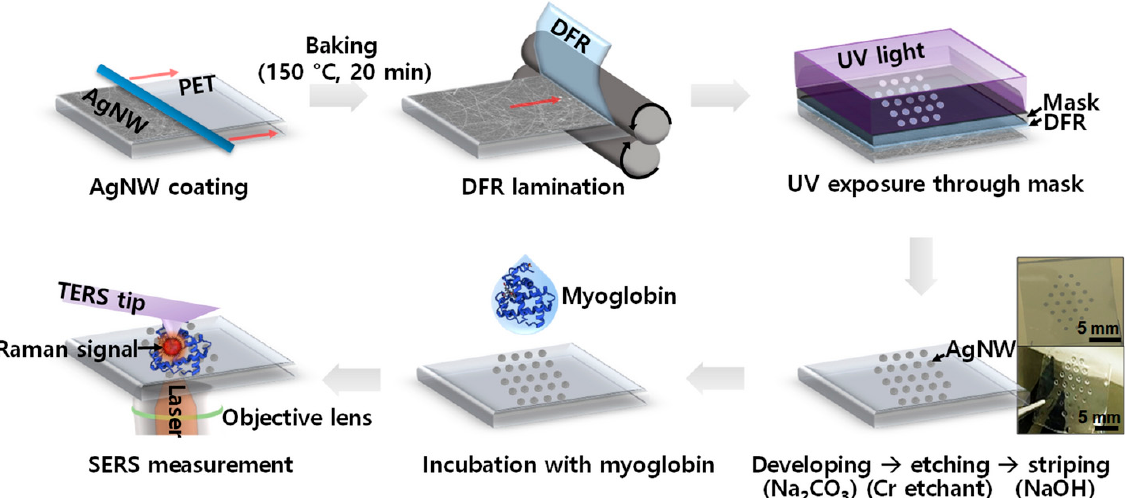
Figure 9. The fabrication of optical biosensors using AgNWs, which is marked by AgNW coating, lamination, UV exposure, etching, striping, incubation, and final measurement. Reproduced from Ref. [56] under the Creative Commons Attribution 4.0 International (CC BY 4.0) License.